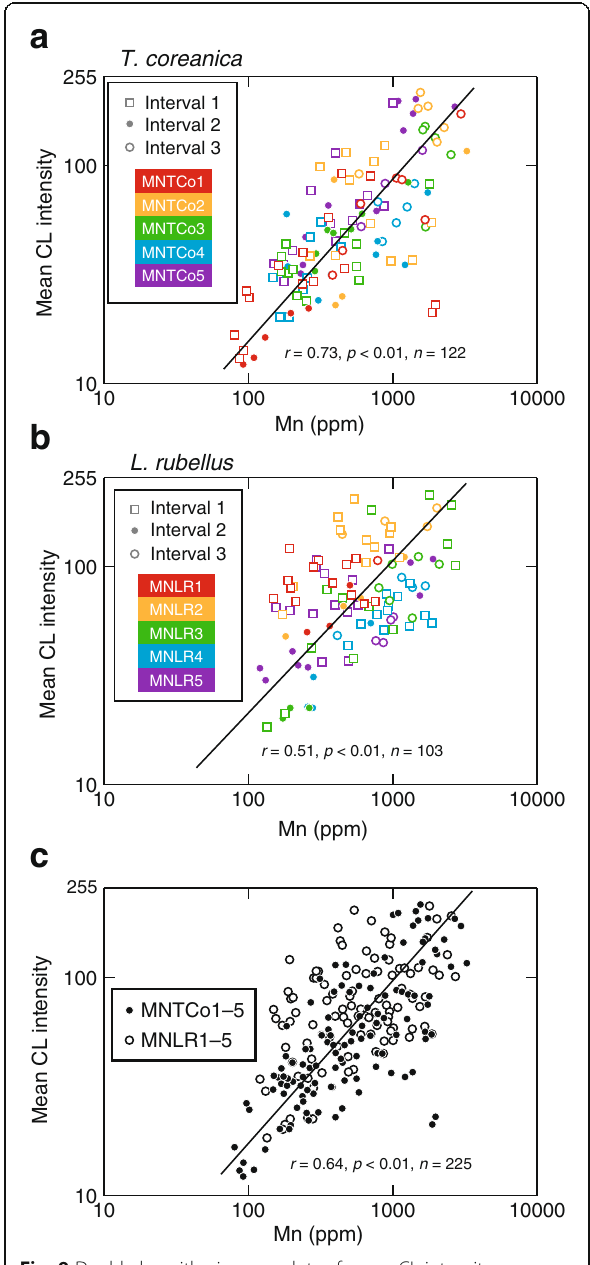
Fig. 9 Double-logarithmic cross-plots of mean CL intensity versus Mn concentration in the studied fossil shells. a T. coreanica . b L. rubellus . c Combined data from both